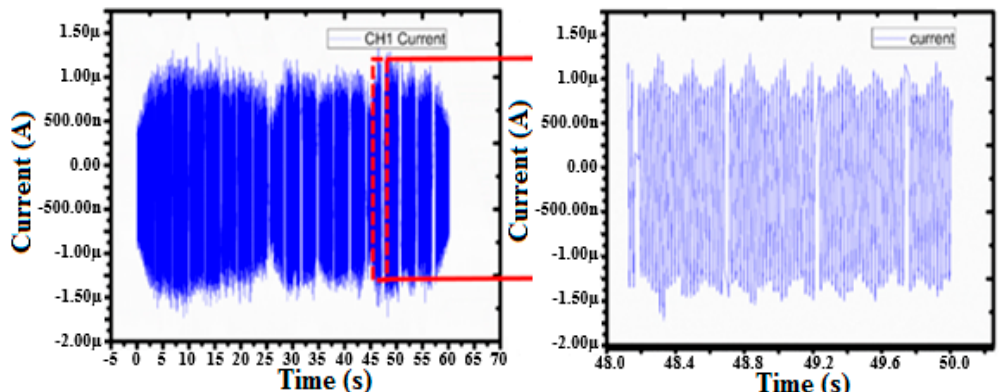
Figure 9. Short circuit analysis of the TENG at a speed of 251 rpm, and a temperature difference of 45 °C.